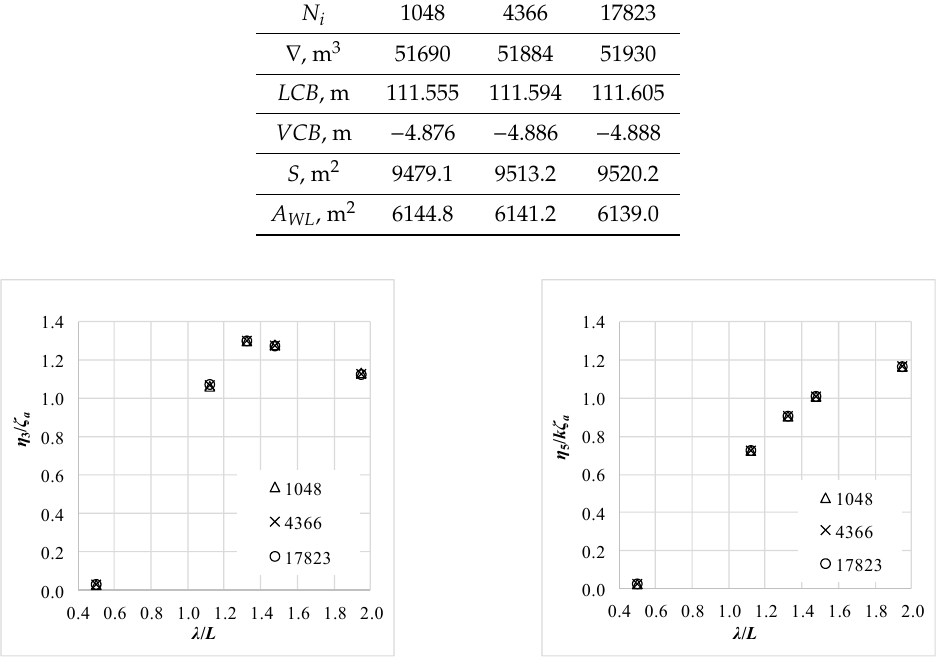
Figure 6. Heave ( left ) and pitch ( right ) transfer functions obtained using di ff erent panel Figure 6. Heave (left) and pitch (right) transfer functions obtained using different panel models. Table 3. Convergence study for panel size used to discretize KCS.